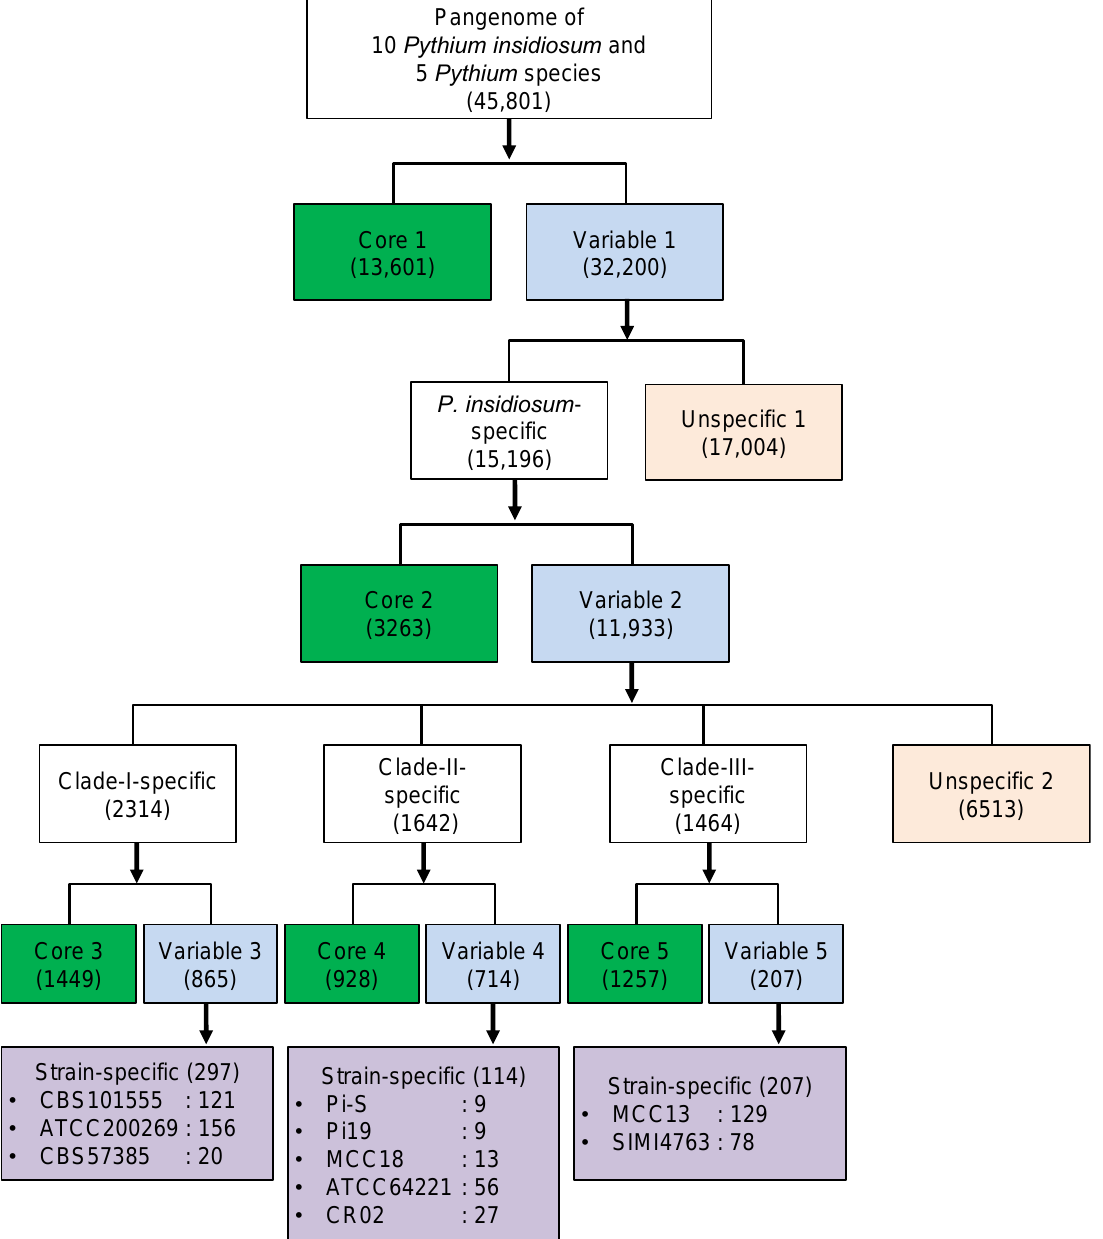
Figure 5. Core and variable genes among 10 P. insidiosum strains and 5 other Pythium species. Green boxes represent core genes (i.e., Cores 1, 2, 3, 4, and 5) present in all genomes at each level. Light blues show variable genes (i.e., Variables 1, 2, 3, 4, and 5), which present at least one but not all of the genomes at each level. Variable genes can be classified into species-specific, clade-specific, strain-specific, and unspecific groups.